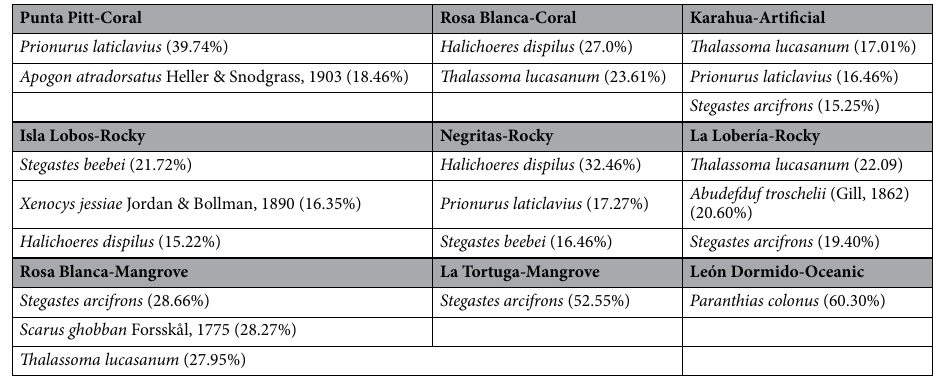
Table 2. Relative abundance (%) of most abundant fish species at each sampling